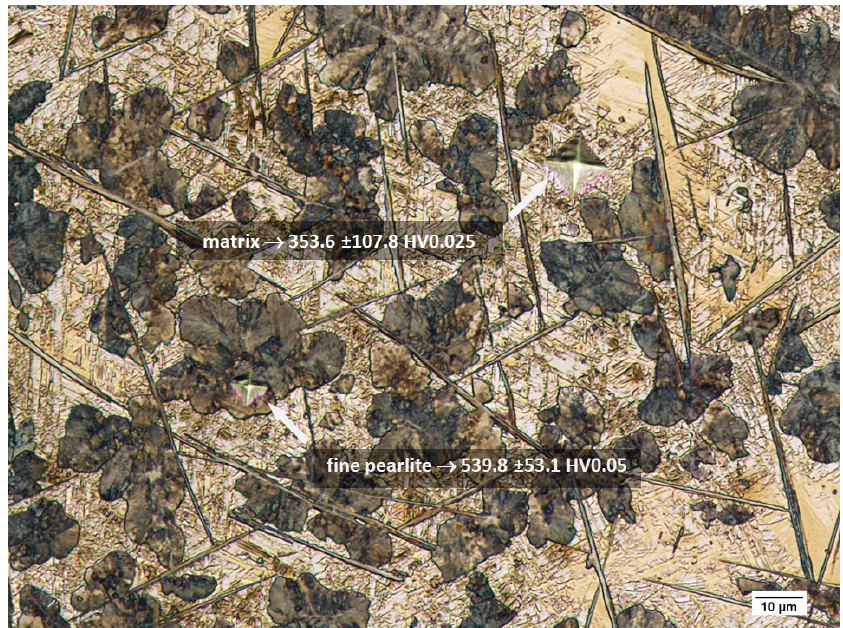
Figure 10. Microstructure of the X120Mn12 steel after isothermal annealing at 510 °C and cooling with the furnace, along with the determined microstructure components subjected to the microhardness measurements. Etched state. LM.